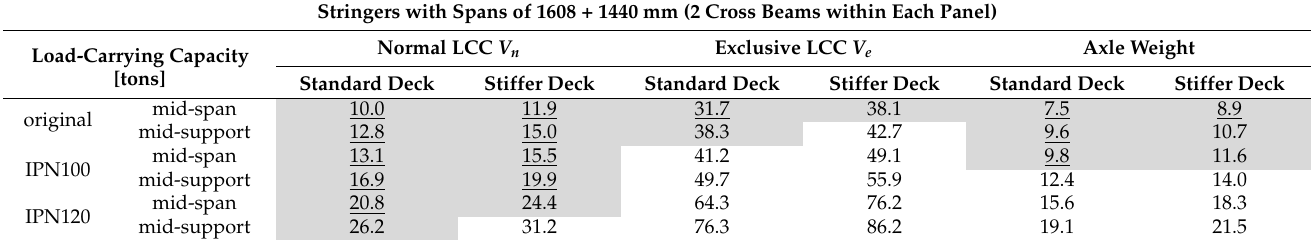
Table 5. Stringer load-carrying capacity for panels with 2 cross beams.